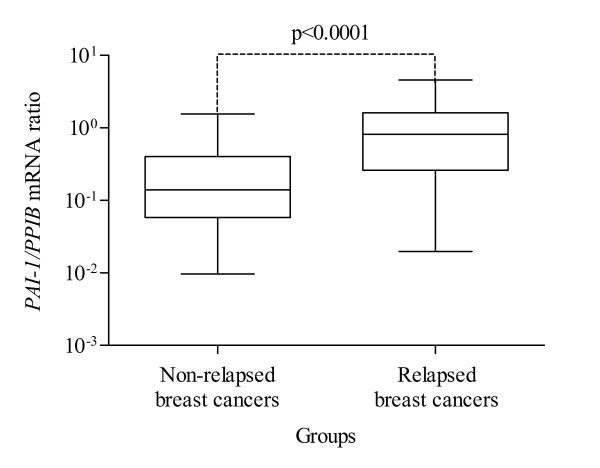
PAI-1 mRNA expression in relapsed and non-relapsed breast cancer patients as measured by quantitative RT-PCR. Differential PAI-1 gene expression between relapsed (n = 30) and non-relapsed (n = 57) patients with MFS as end-point (Mann-Whitney test; p < 0.0001).